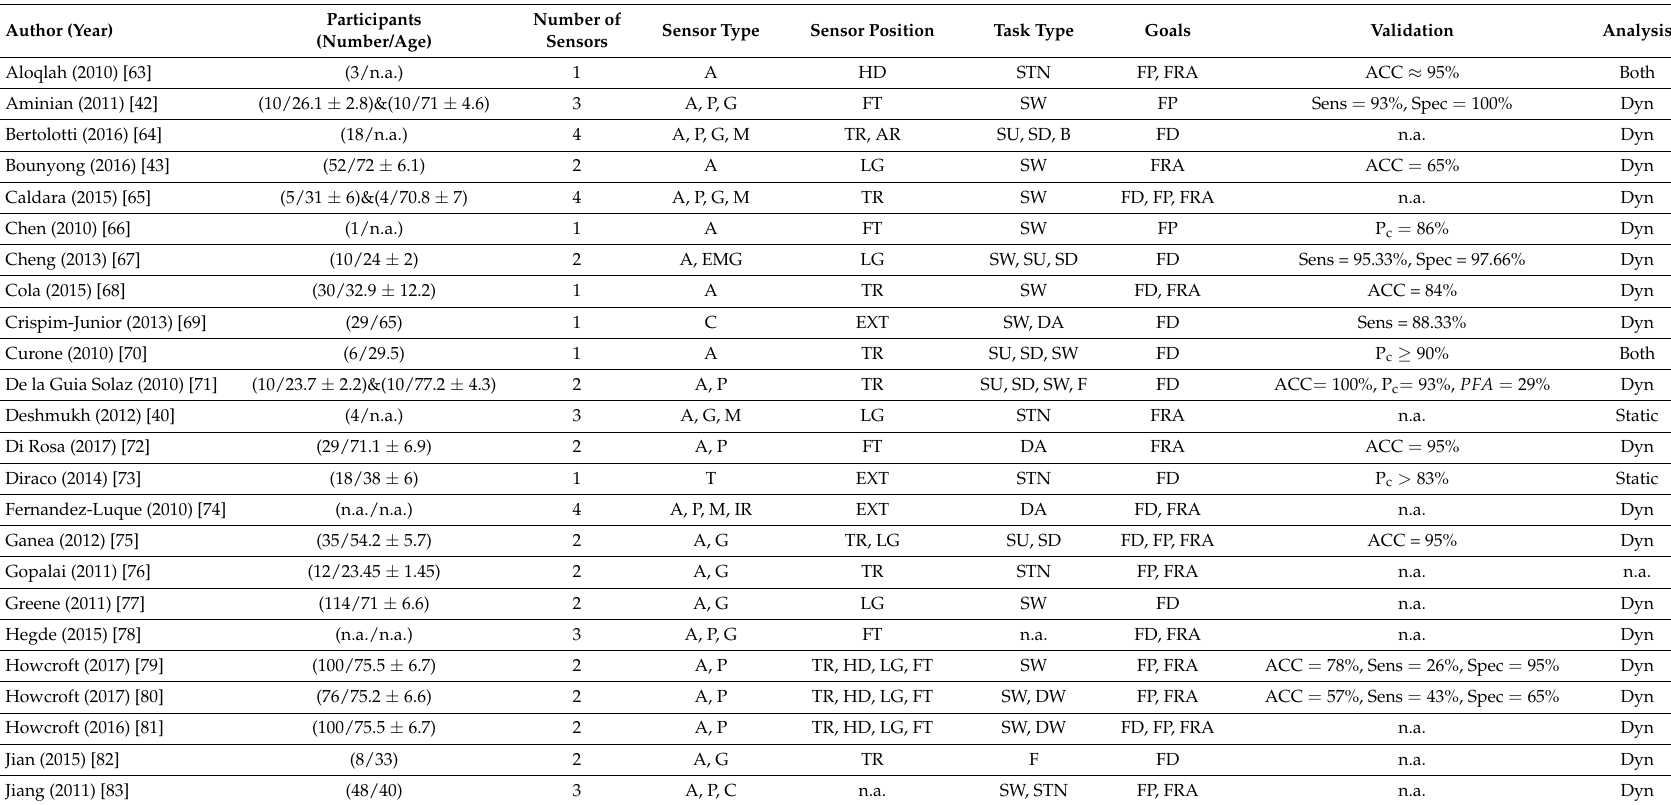
Table 1. Summary of the wearable sensor-based systems for stability control in elderly people for the considered bibliographic research. Task types include the main activities proposed in the articles both for the dynamic as well as static analyses and reported in Tables 2 and 3. In some cases, both methodologies have been adopted. The manuscripts have been classified according to the main identified aims, i.e. fall risk assessment (FRA), fall detection (FD) and fall prevention (FP). Acronyms for the Validation column: ACC = accuracy, Sens = sensitivity, Spec = specificity, PFA = Probability of false alarm, P c = Probability of correct decision. Acronyms for the Analysis column: Dyn =